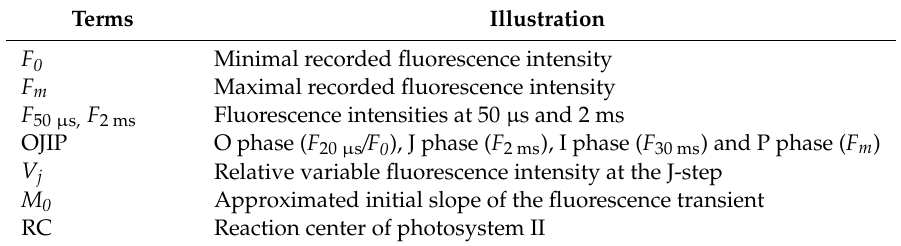
Table 1. Parameters used in the analysis of OJIP fluorescence induction dynamics curves [21,22,30]. Terms Illustration F 0 Minimal recorded fluorescence